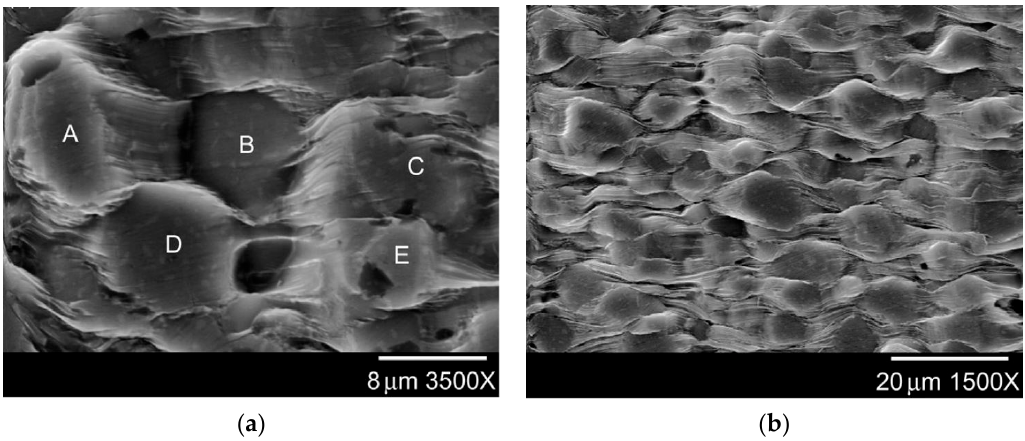
Figure 14. SEM micrographs showing surface morphologies of FSP 7075Al superplastically deformed to ( a ) an elongation of 200% and ( b ) an elongation of 400% [136].